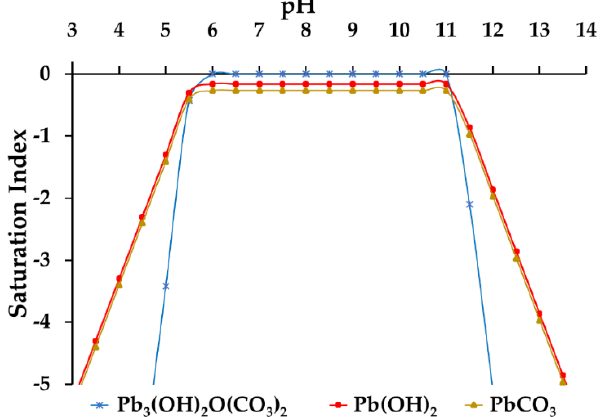
Figure 10. Distribution diagram of Pb(II) species as a function of pH. [Pb(II)]: 400 mg / L obtained with the MINEQL program.